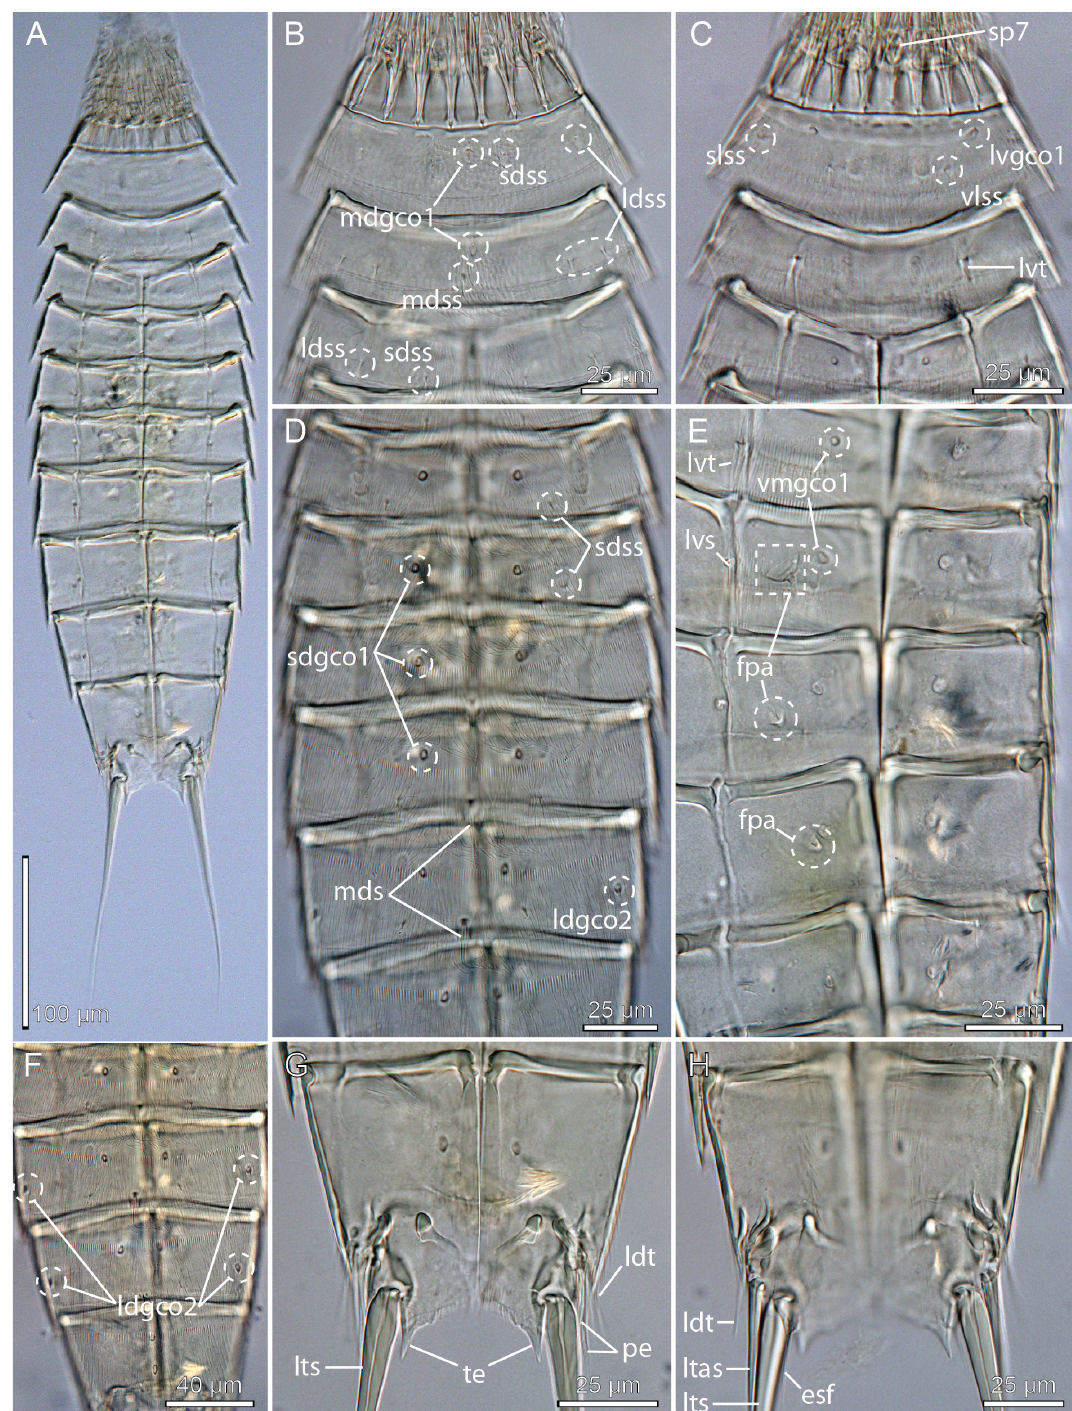
Fig. 2. Light micrographs showing overviews and details of Echinoderes dujardinii Claparède, 1863, non-types from Ria Formosa, Faro, Portugal. A–D, F–G . ♂ (NHMD-616804). E, H . ♀ (NHMD-616824). A . Ventral overview. B . Segments 1 to 3, dorsal view. C . Segments 1 to 3, ventral view. D . Segments 4 to 9, dorsal view. E . Segments 5 to 9, ventral view, showing female sexual dimorphism. F . Segments 7 to 10, dorsal view. G . Segments 10 to 11, ventral view, showing male sexual dimorphism. H . Segments 10 to 11, ventral view, showing female sexual